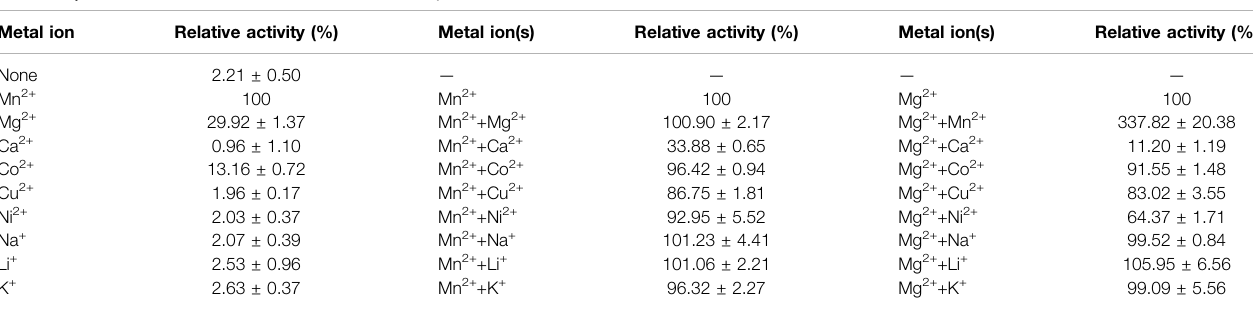
TABLE 3 | The effects of different metal ions on the activity of